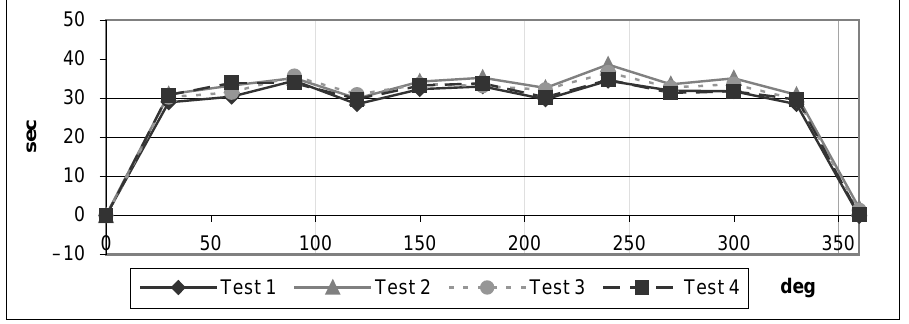
Fig 3. Graphs of the circular scale errors (20 02 2006)